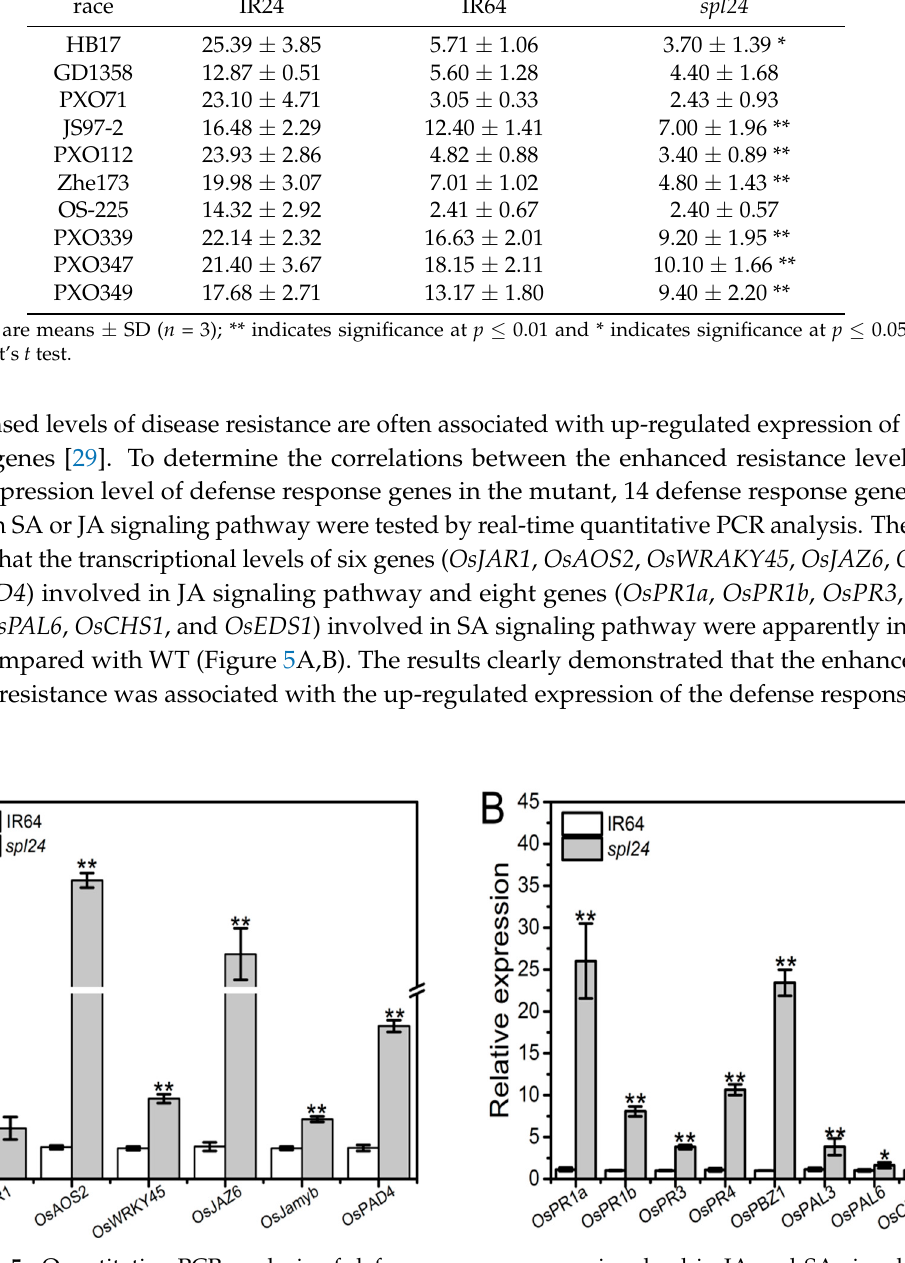
Figure 5. Quantitative PCR analysis of defense response genes involved in JA and SA signaling pathways. ( A ) Expression analysis of genes in JA pathway at the heading stage; ( B ) expression analysis of genes in SA pathway. The expression level of each gene in the wild-type was normalized to 1. Values indicate means ± SD ( n = 3). * denotes P ≤ 0.05, and ** denote p ≤ 0.01 by Student’s t test. Table 2. Evaluation of disease resistance to Xanthomonas oryzae pv. oryzae .